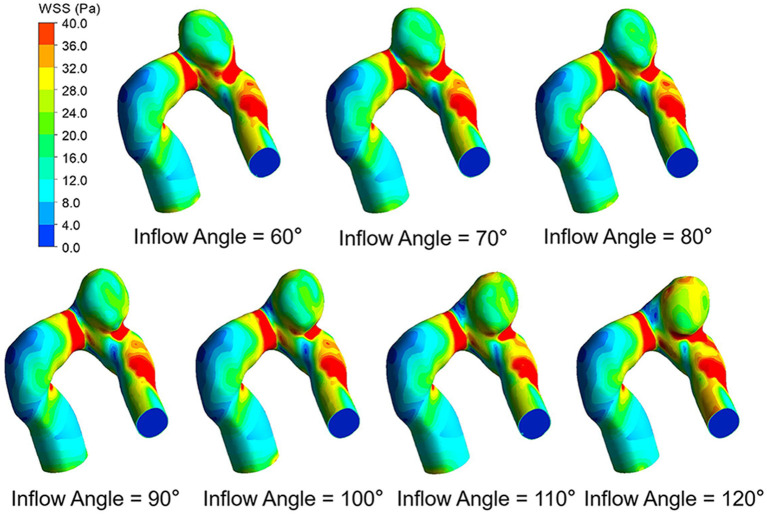
WSS distributions of seven IA models with different inflow angles at peak systole.